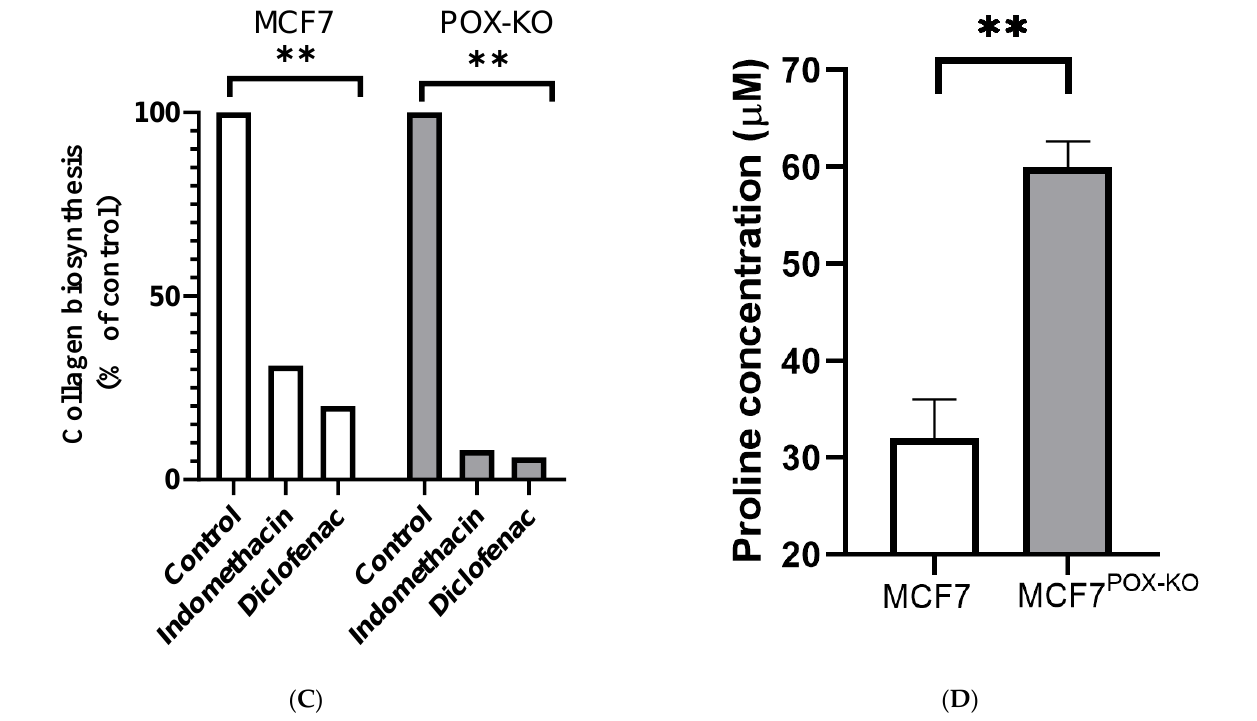
Figure 1. Cell viability ( A ), DNA biosynthesis ( B ), and collagen biosynthesis ( C ) in MCF-7 and MCF7 POX-KO cells treated for 24 h with 0.5 mM indomethacin and 0.375 mM diclofenac. Cellular proline concentration determined by HPLC-MS ( D ). The mean values ± standard error (SEM) from the 3 experiments, performed in triplicates, are presented at * p < 0.05 and ** p < 0.005.